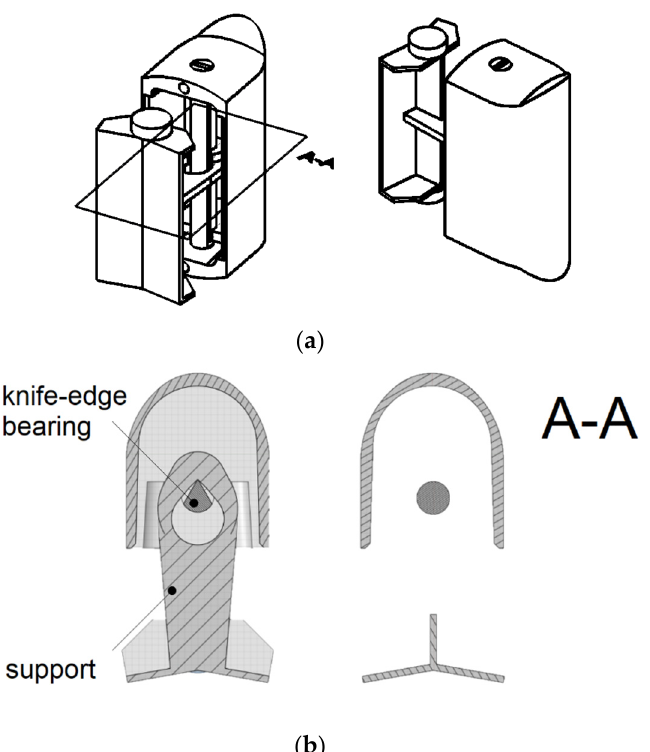
Figure 7. Geometry of the oscillator: ( a ) real geometry, isometric views, A–A symmetry plane is marked; ( b ) comparison of the real geometry in the A–A symmetry plane and the geometry of a 2D model.